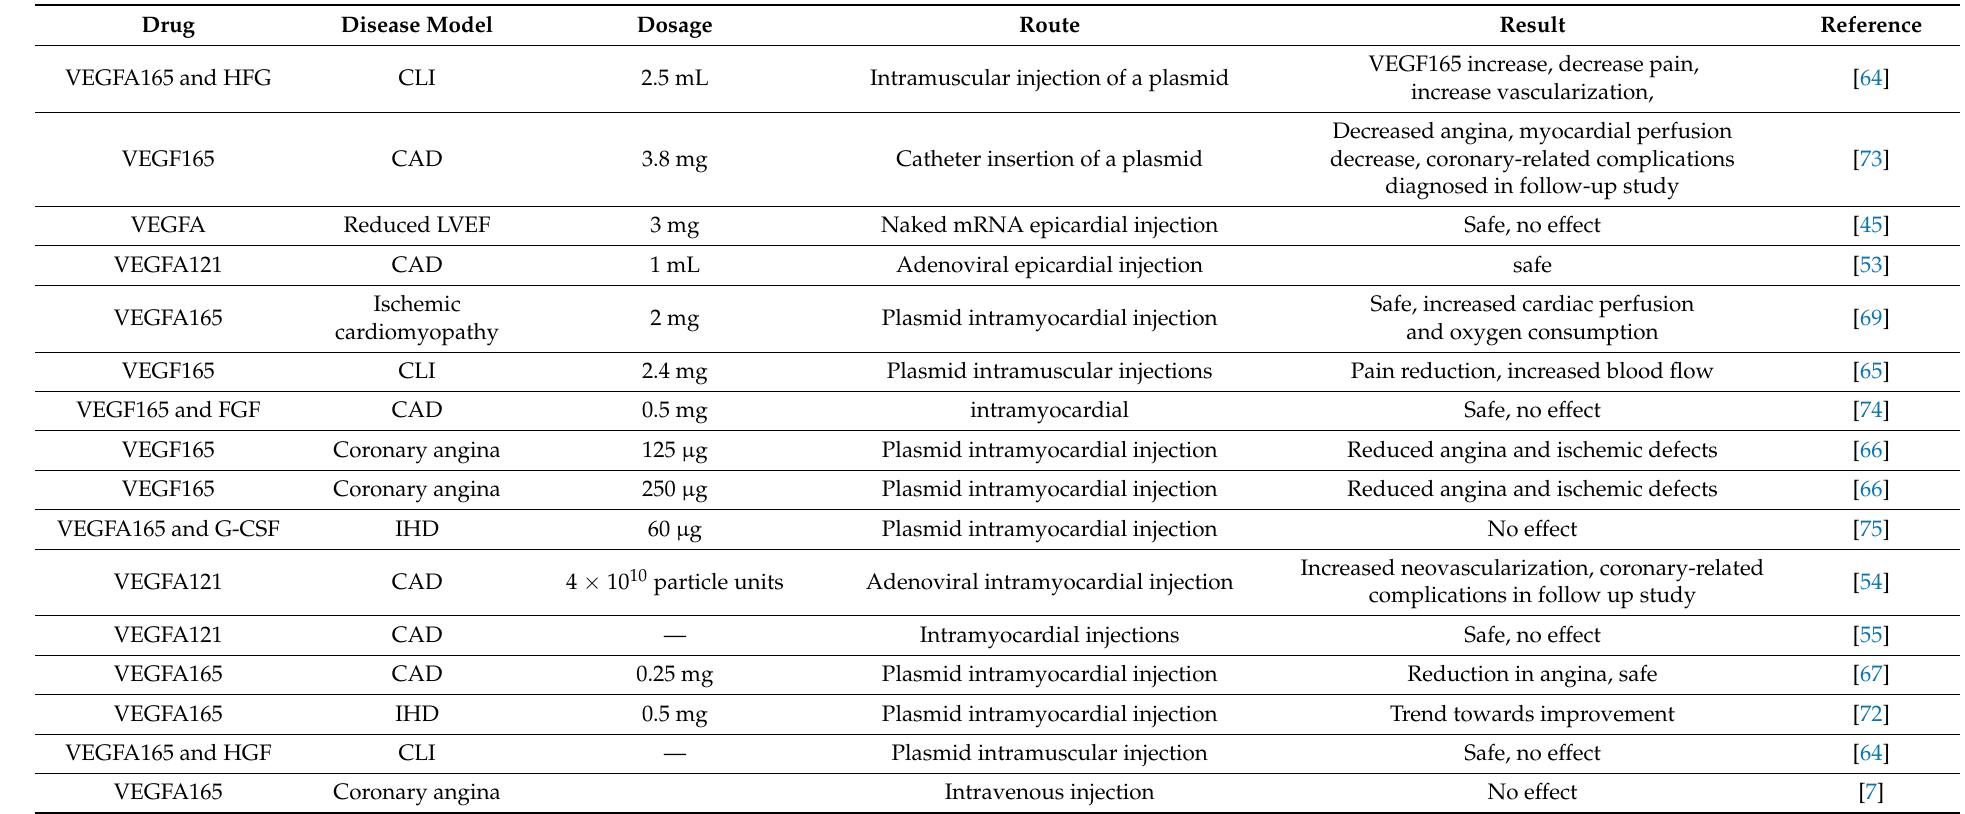
Table 3. Varying effects of VEGFA pro-angiogenic therapy in clinical trials. Results from clinical trials using pro-angiogenic vascular endothelial growth factor A (VEGFA) therapy to treat patients with different afflictions vary. CLI: Critical Limb ischemia. CAD: coronary artery disease. LVEF: left ventricular ejection